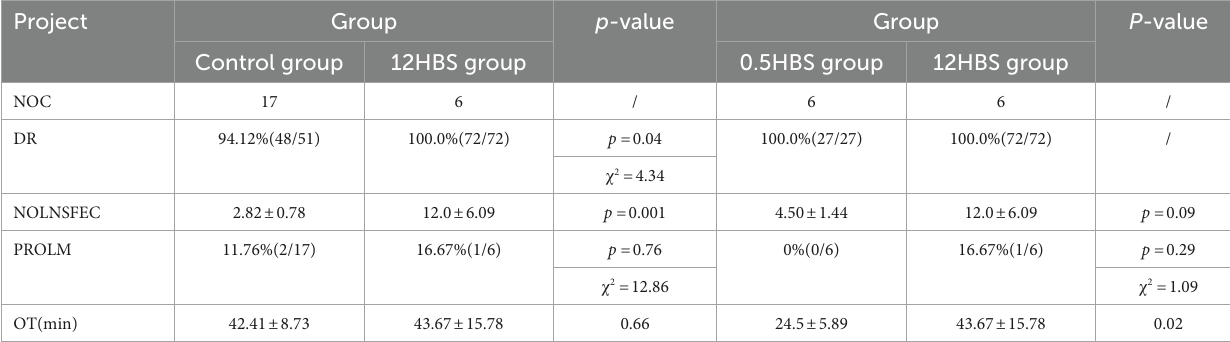
TABLE 2 Data of different groups and statistical analysis results.